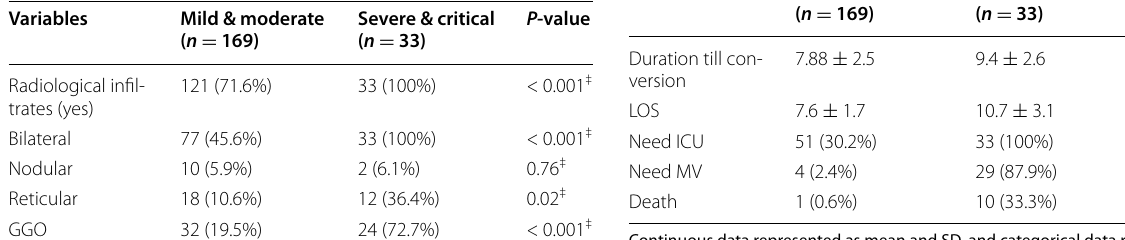
Table 3 Chest x-ray and CT abnormalities of studied COVID-19 patients